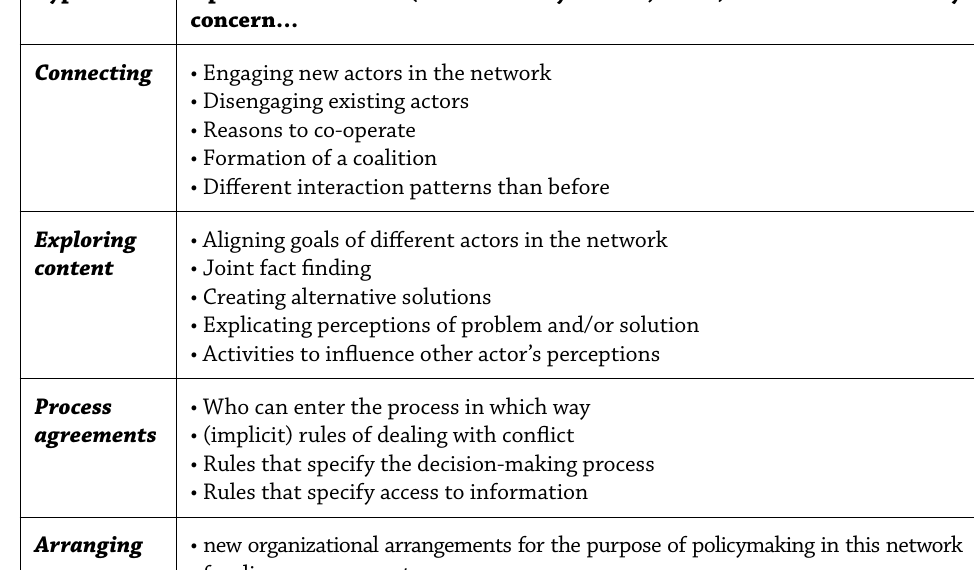
Table 1. Four different strategy types and the operationalization in this study